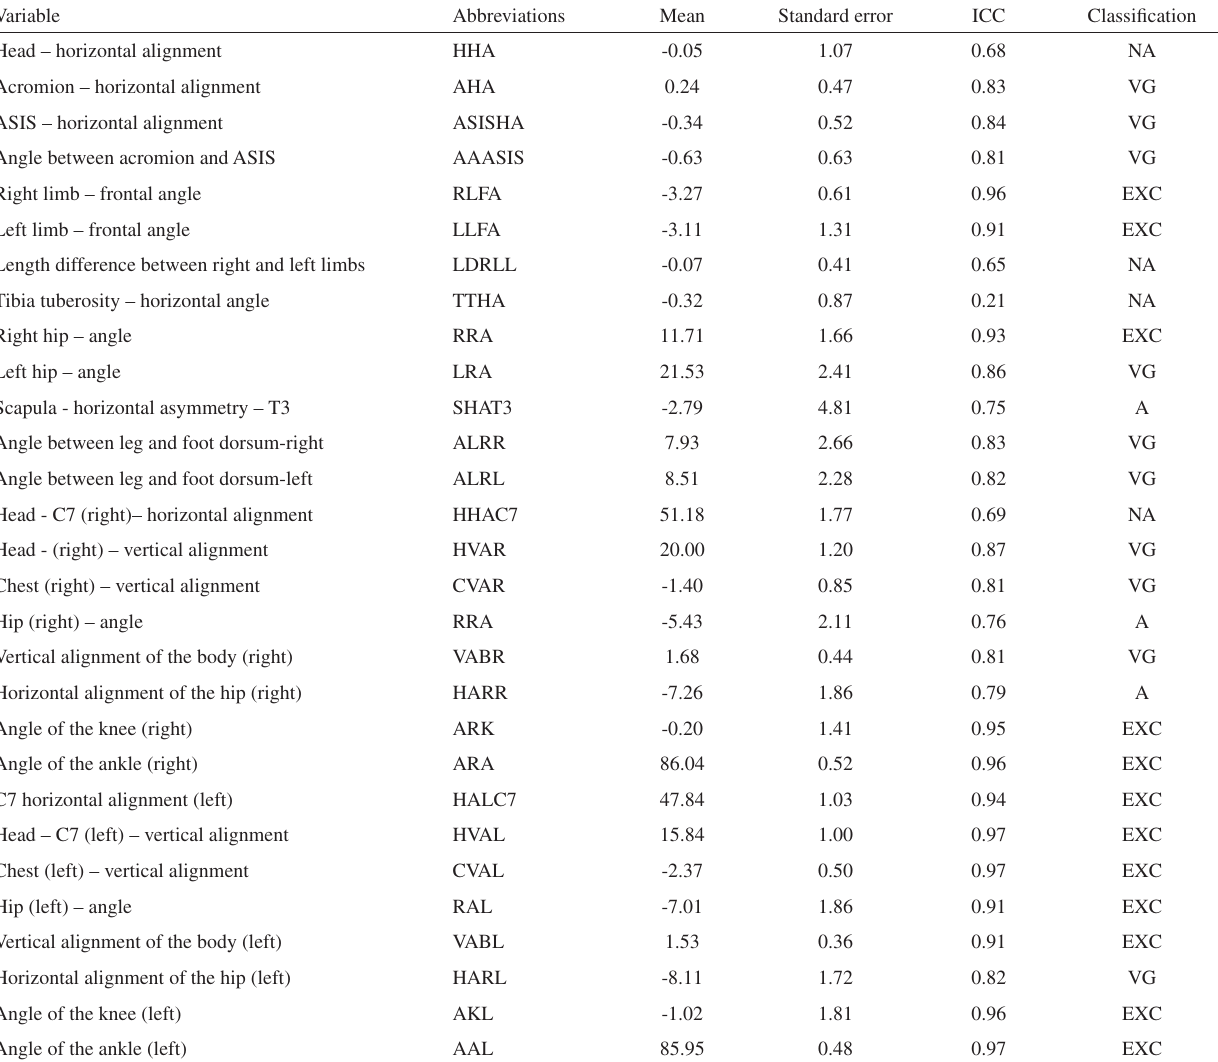
Table 1 - Inter-rater reliability: mean, standard error, ICC and respective